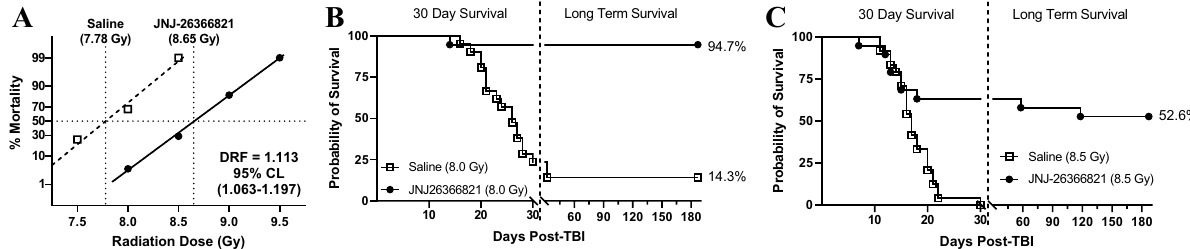
Figure 5. Dose reduction factor and long term survival in C57BL/6 male mice. (A) DRF analysis of animals administered JNJ-26366821 at 1 mg/kg ( ■ ) or saline as a vehicle ( □ ) 24 h post-TBI. Probit analysis was performed using IBM SPSS statistical analysis software and estimated survival was plotted as dashed lines (Saline) or Solid lines (TPOm). LD50/30 values were determined to be 7.78 Gy and 8.65 Gy for Saline and JNJ- 26366821, respectively yielding a DRF value of 1.113. N = 24 mice per group. (B) 30 day and 6 month survival data for animals administered Saline ( □ ) or JNJ-26366821 ( ■ ) 24 h after irradiation at 8.0 Gy. Kaplan–Meier survival curves were plotted using GraphPad software; n = 19–22 mice per group and the trend in survival was compared between vehicle and drug-treated groups (Log-rank test p < 0.0001). (C) 30 day and 6 month survival data for animals administered Saline ( □ ) or JNJ-26366821 ( ■ ) 24 h after irradiation at 8.5 Gy. Kaplan– Meier survival curves were plotted using GraphPad software; n = 19–24 mice per group and trend in survival is compared between vehicle and drug-treated groups (Log-rank test p = 0.0003). Figures were plotted using GraphPad Prism 9 software V9.0.2; www. graph pad. difference was observed between counts in the irradiated groups ( p = 0.1080). Finally, the highest platelet counts were observed in naïve animals (1364 ± 170 × 10 3 cells/μl) and counts in naïve group were significantly higher than counts in either irradiated group (saline 209 ± 86 × 10 3 cells/μl, p = 0.0020 and JNJ-26366821 463 ± 189 × 10 3 cells/μl, p = 0.0036); the counts in irradiated groups were not statistically different from one another ( p = 0.1011). For all cell type counts, the prevailing trend was naïve > JNJ-26366821 > saline. Analysis of the total colony forming units (CFU-GM, CFU-GEMM, CFU-E, and BFU-E) in the bone mar- row of these animals (Fig. 4C) demonstrated highest counts in naïve animals (20.5 ± 3.1) that were significantly elevated relative to animals administered saline (0.25 ± 0.50, p = 0.0006) or JNJ-26366821 (7.8 ± 2.6, p = 0.0150). CFU counts were also higher in animals administered JNJ-26366821 over those in animals administered saline ( p = 0.0109). Similarly, circulating FLT3-L, as assessed by ELISA in serum (Fig. 4D), was significantly higher in the saline (4065 ± 1800 pg/ml) group as compared to both the naïve group (368 ± 21 pg/ml, p = 0.0236) and JNJ-26366821 group (1114 ± 191 pg/ml, p = 0.0476); FLT3-L levels were elevated in animals administered JNJ- 26366821 as compared to naïve levels ( p = 0.0025). Finally, megakaryocytes counts (Fig. 4E) in H&E stained